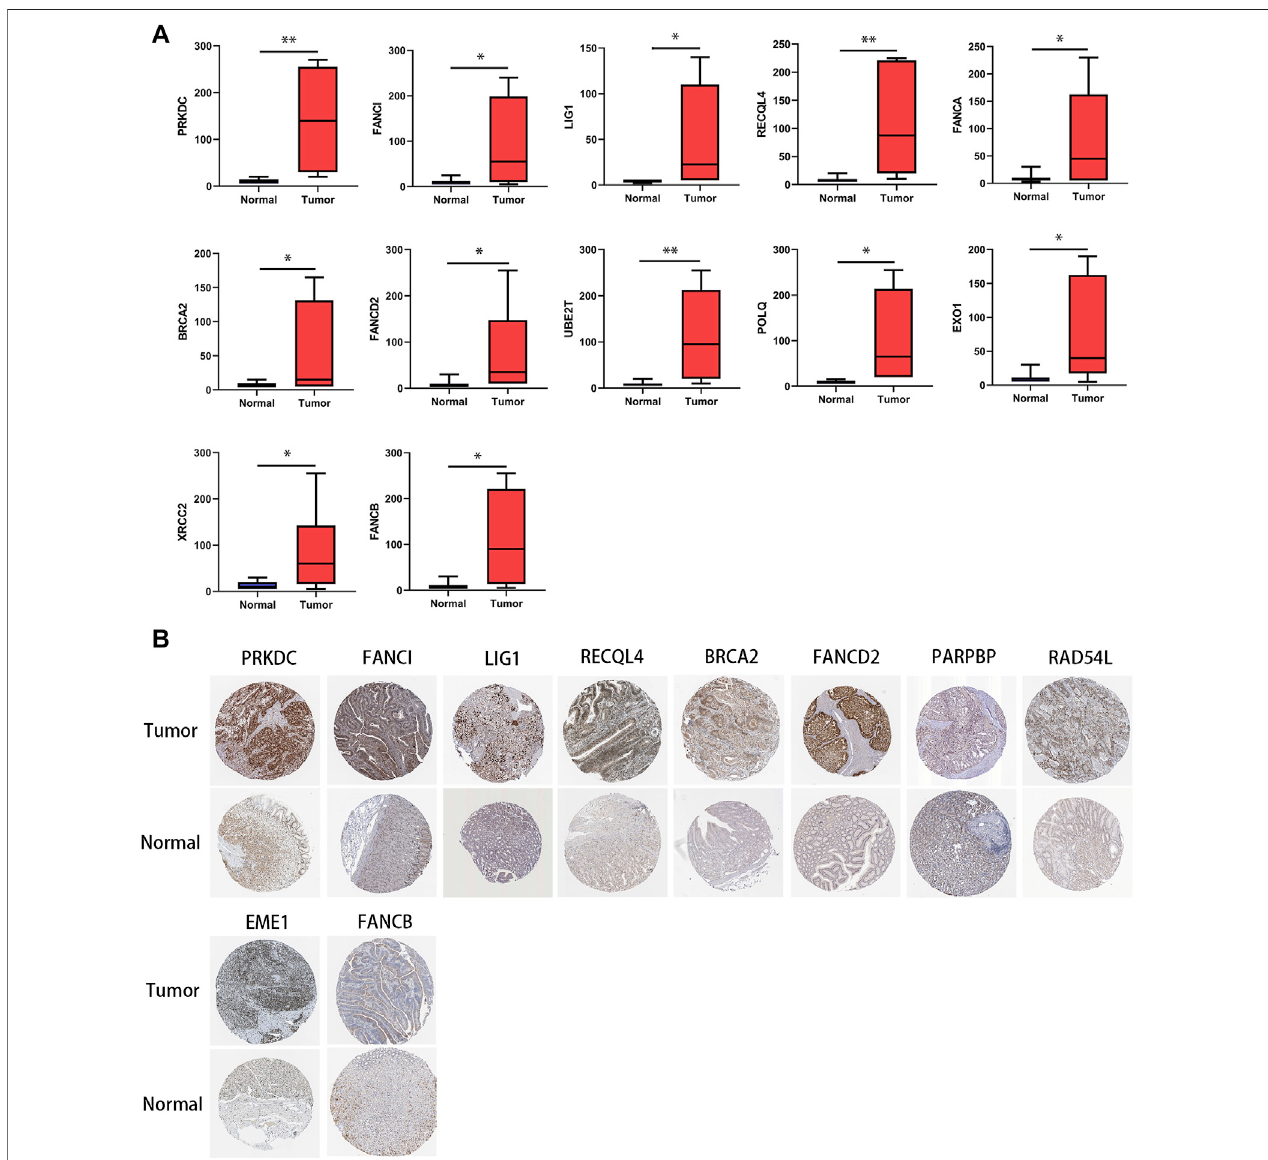
FIGURE9| ProteinlevelofgenesintheDRGSingastriccancertissues andnormaltissues. (A) IHC(Tumor n =10,Normal n =10);(* p < 0.05,** p < 0.01). (B) HPA database.